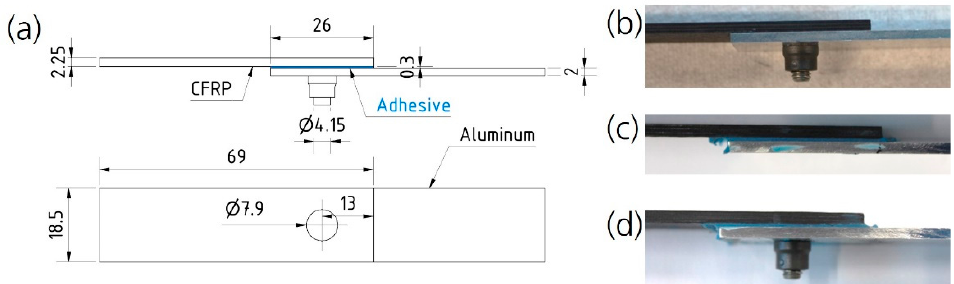
Figure 1. ( a ) Dimensions of a multi-material bonded/bolted specimen (all dimensions are in millimeters); ( b ) multi-material bolted specimen; ( c ) multi-material bonded specimen; and ( d ) multi-material bonded/bolted specimen.